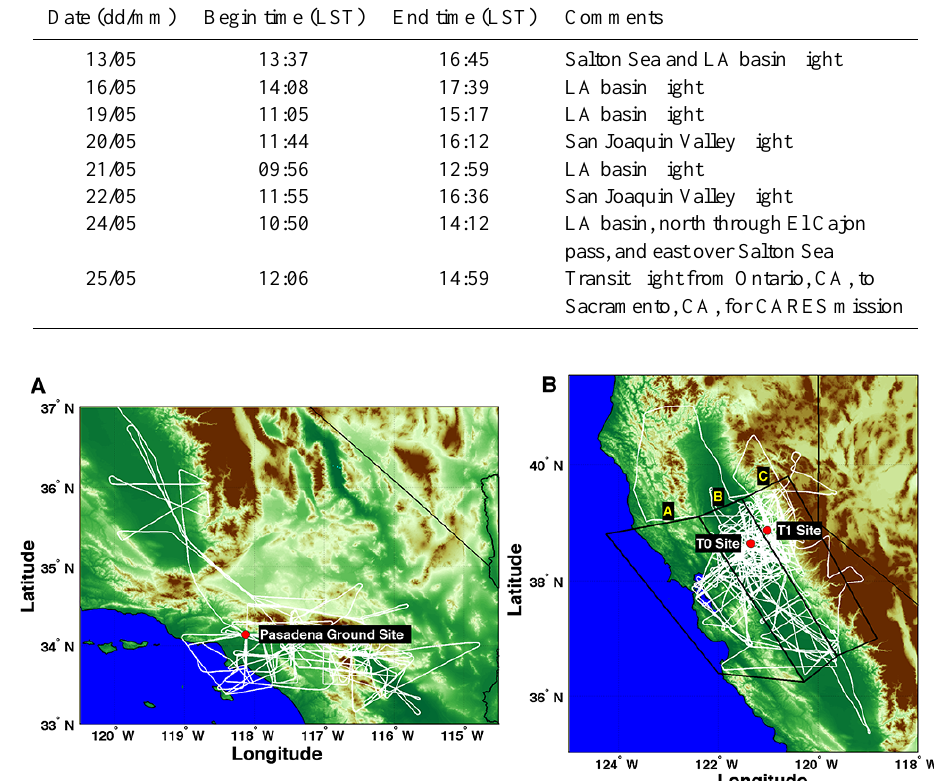
Figure 1. (A) Summary of flight tracks during CalNex and the location of the ground site in Pasadena, CA. (B) Summary of flight tracks during CARES along with the three study regions (A: San Francisco, B: Central Valley and C: Sierra Nevada) discussed in Sect. 3.3 and locations of the two ground sites. In both images, the background behind the flight tracks is elevation (GLOBE digital elevation model), where shades of green represent the lowest elevation and brown is the highest